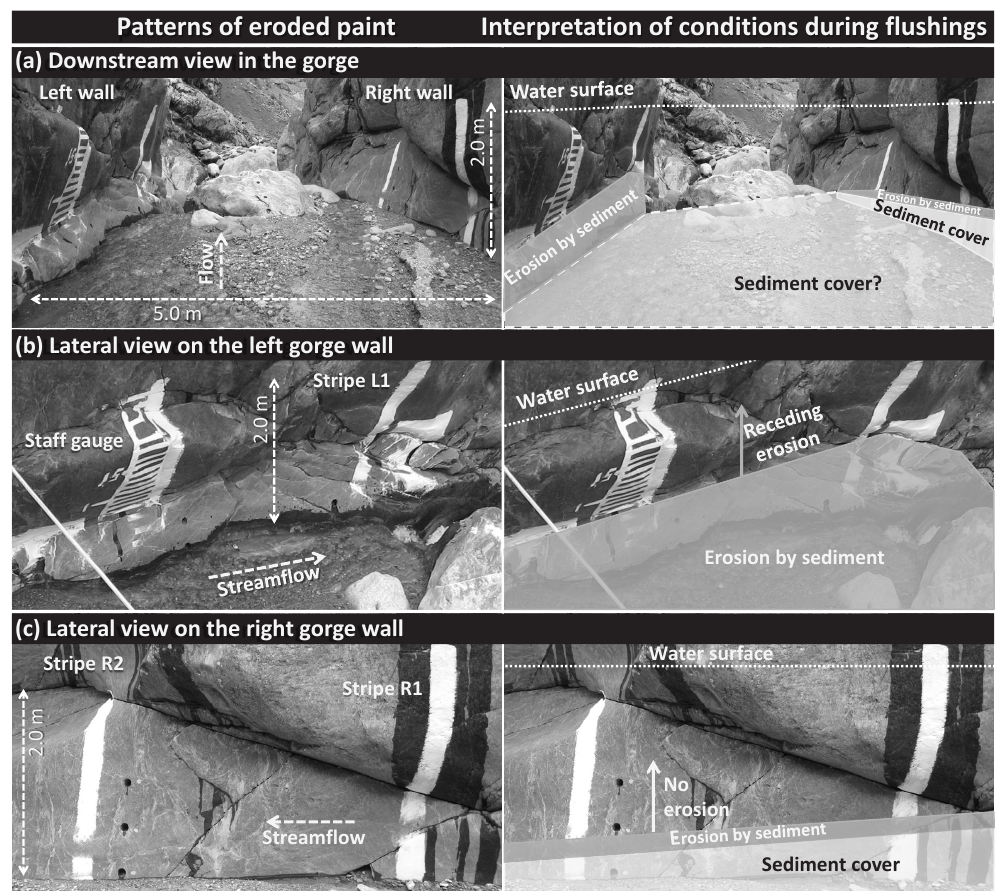
Figure 5. Erosion patterns on the painted stripes in the gorge (left column) reflect likely cross-stream variations in the sediment tools and cover effects during flushings (as indicated by interpretive diagrams in the right column): (a) downstream view into the gorge with four painted stripes visible (cf. Fig. 1d), (b) lateral view of the left bedrock wall, and (c) lateral view of the right bedrock wall. All pictures show paint erosion over the period of 6 June to 9 July 2014. The dark areas in (a) and (c) are wet rock sections due to seepage from